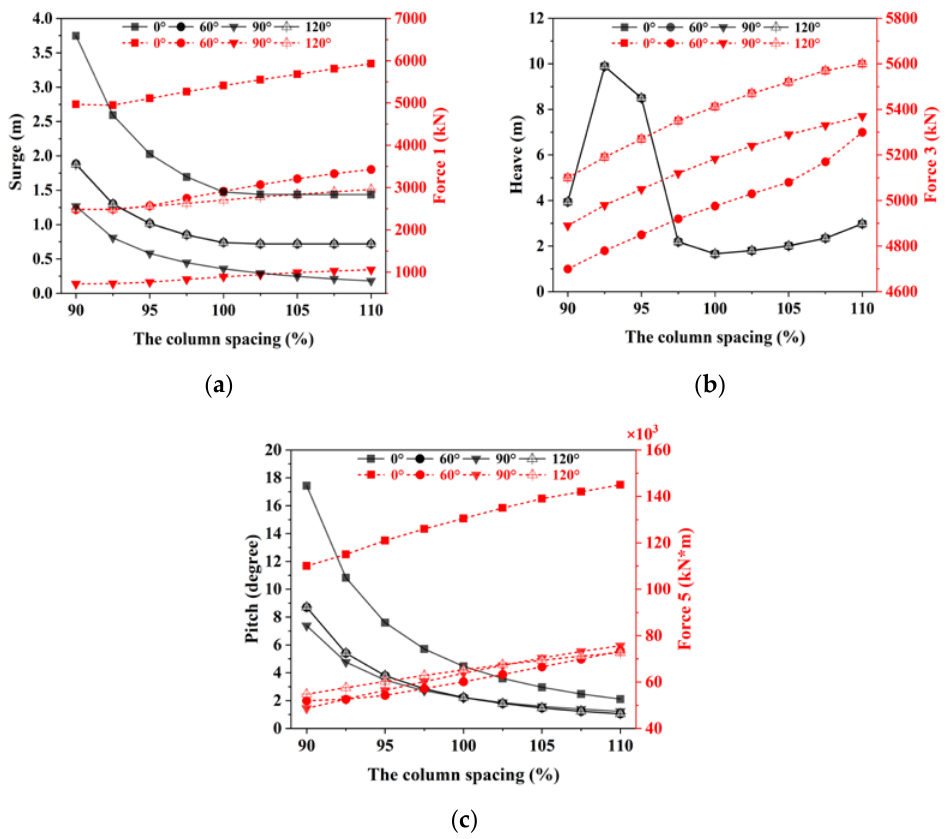
Figure 9. The peak values of the transfer functions with different column spacing in the different wave directions: ( a ) Peak values of surge motion and Force 1 transfer functions; ( b ) peak values of heave motion and Force 3 transfer functions; ( c ) peak values of pitch motion and Force 5 transfer